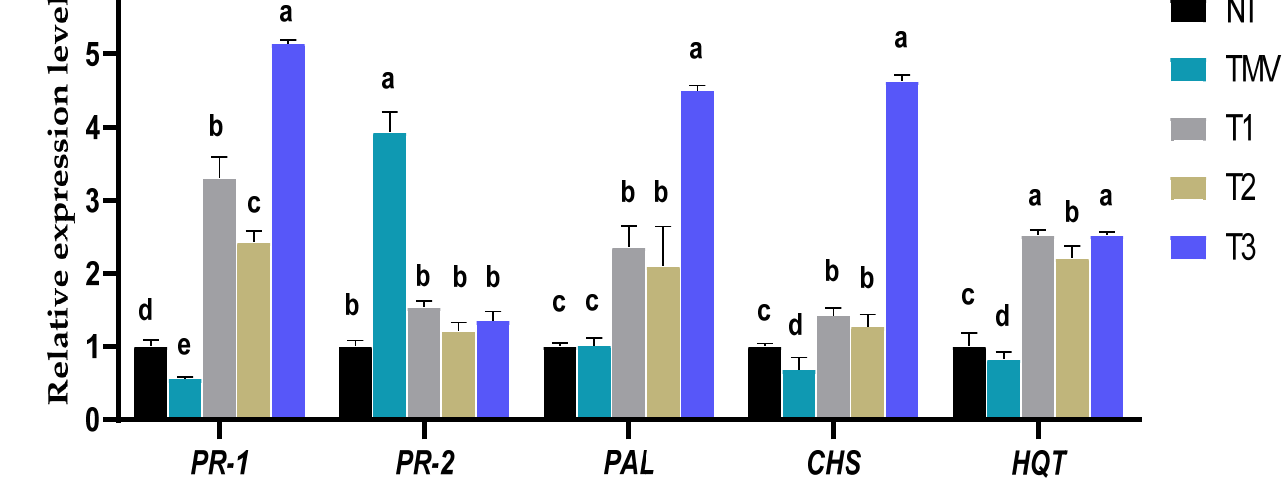
Figure 6. The relative expression levels of genes encoding pathogenesis-related proteins ( PR-1 , and PR-2 ) and polyphenol biosynthetic enzymes ( PAL , CHS , and HQT ) in tomato plants at 22 days post- TMV inoculation. NT: mock plants; TMV: virus-infected plants; T1: tomato plants sprayed with bacterial culture filtrate 24 h before virus infection; T2: tomato plants sprayed with bacterial culture filtrate after 24 h of virus infection; T3: tomato plants sprayed with bacterial culture filtrate two times, 24 h before and 24 h after virus inoculation. Each column value represents the mean result obtained from five biological replicates. Significant differences were calculated using a one-way ANOVA according to the least significant difference (LSD) method at a p ≤ 0.05 level of probability with the GraphPad Prism software package. The mean values of each column with the same letter do not differ significantly.